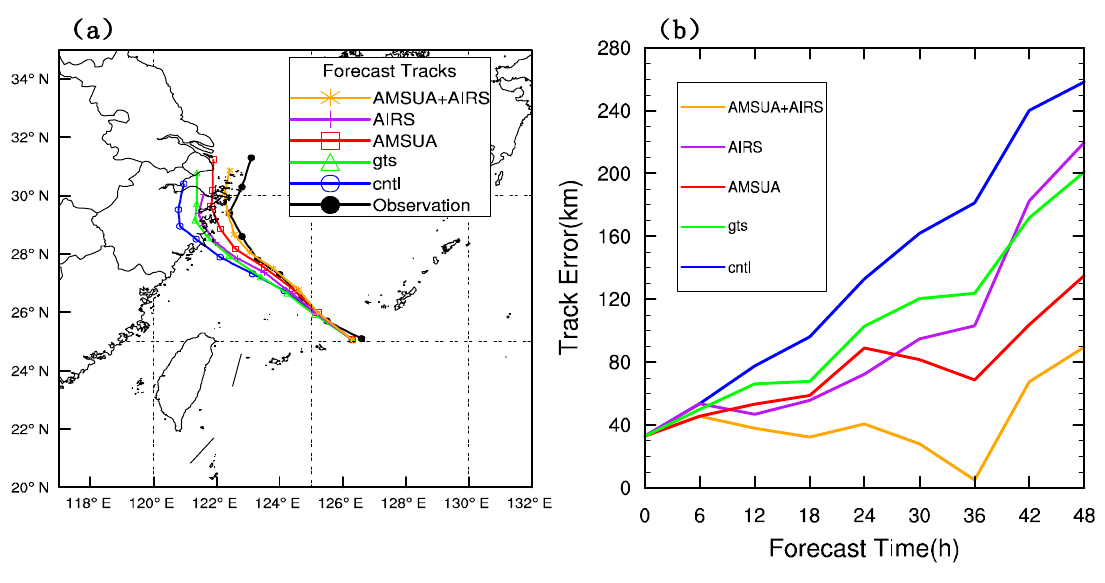
Figure 11. ( a ) Track forecast and ( b ) track error (unit: km).